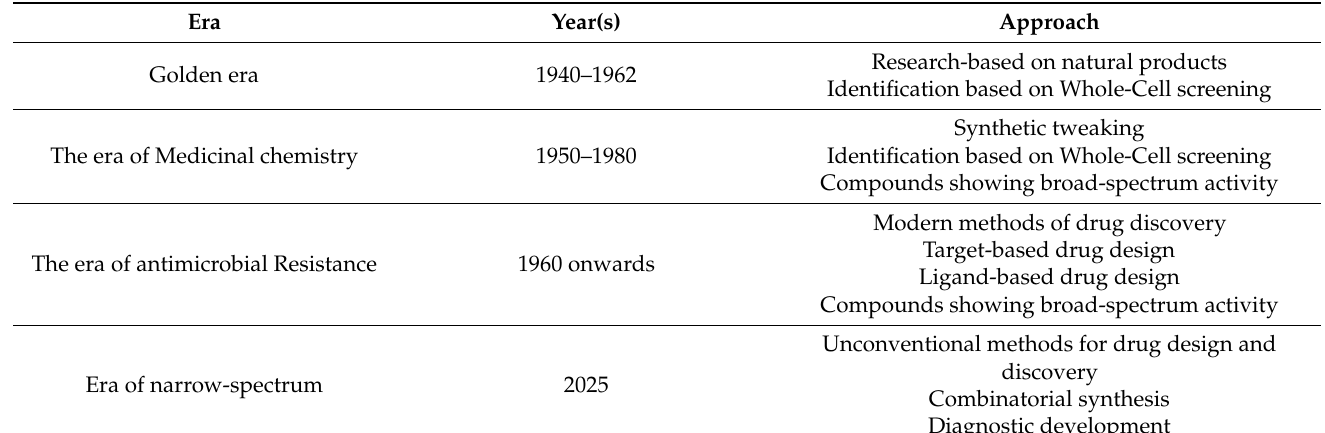
Table 1. The various timeline-dependent strategies implemented for antimicrobial drug